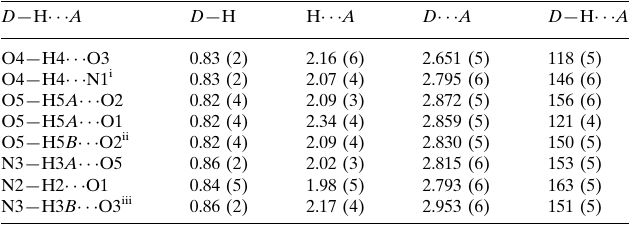
Hydrogen-bond geometry (A˚ , (cid:3)